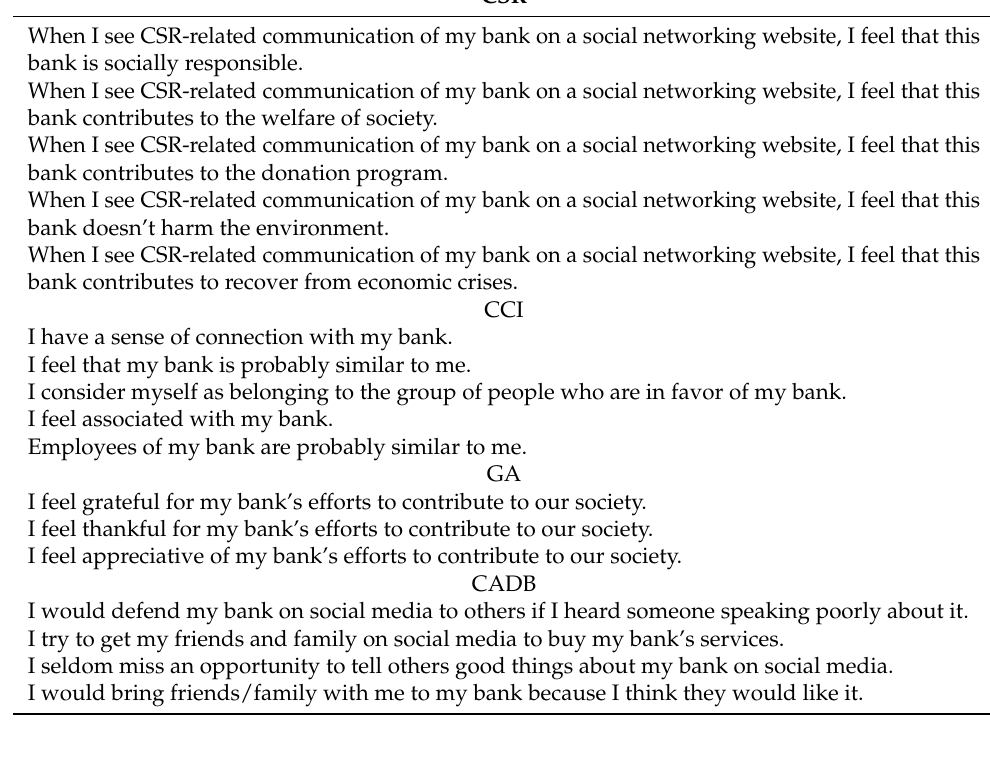
Table A1. Variable items used in this